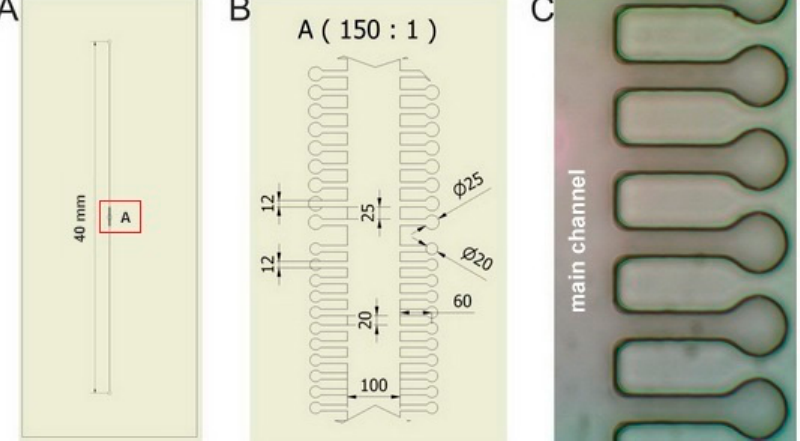
Figure 2. Microfluidic chip used in the optical trapping experiments. ( A )—The design of the microfluidic chip. Total length of the main channel: 40 mm; ( B )—a detail of the central part of the chip contained within the red rectangular region shown in part A (dimensions in μ m); ( C )—a microscope image of individual micro-chambers in the chip and adjacent main channel.